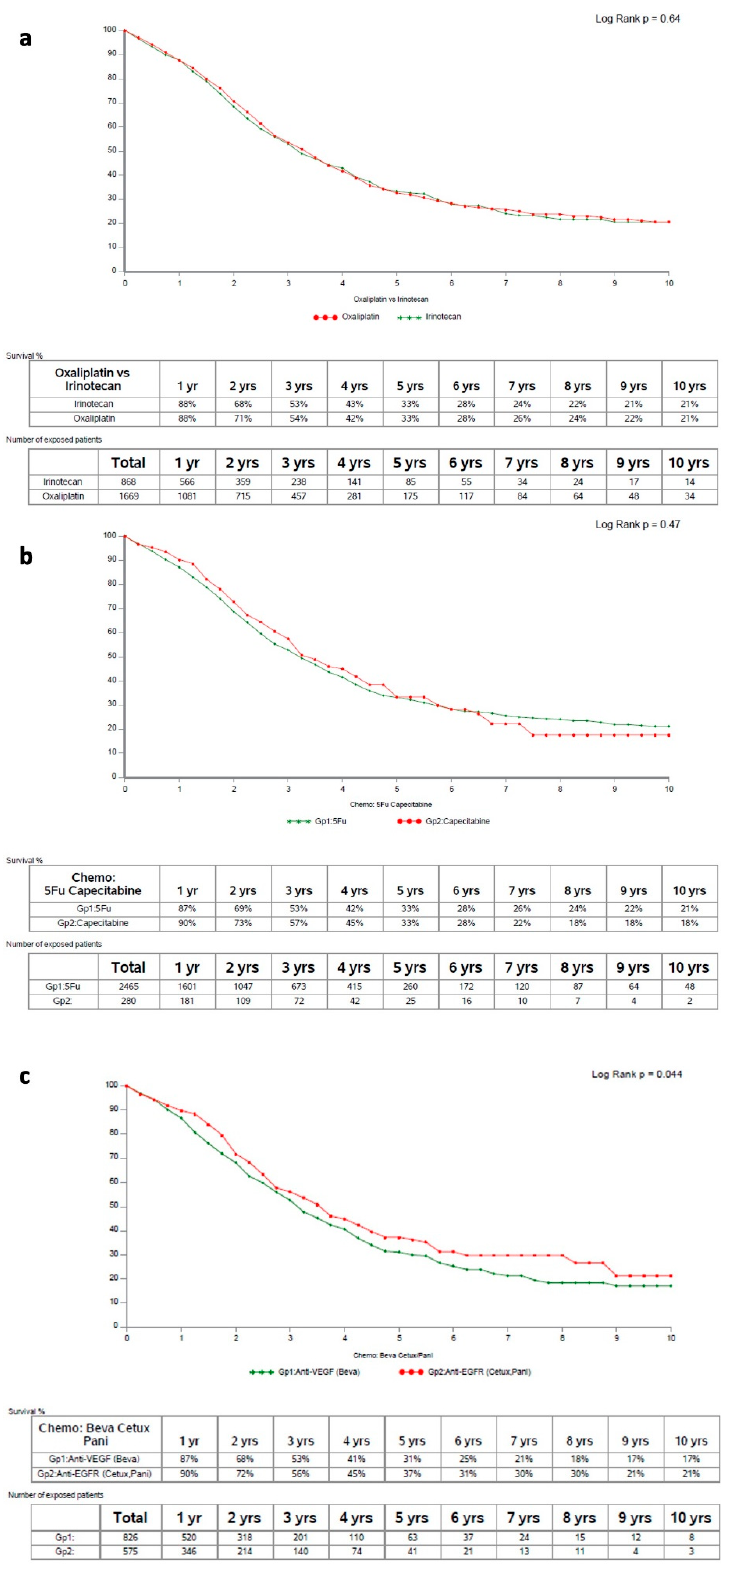
Figure 3. Overall Survival curves according to considered PO-SACT modalities: panel ( a ): oxaliplatin versus irinotecan; panel ( b ): 5-fluorouracil versus capecitabine; panel ( c ): cetuximab/panitumumab versus bevacizumab. PO-SACT: pre-operative systemic anticancer